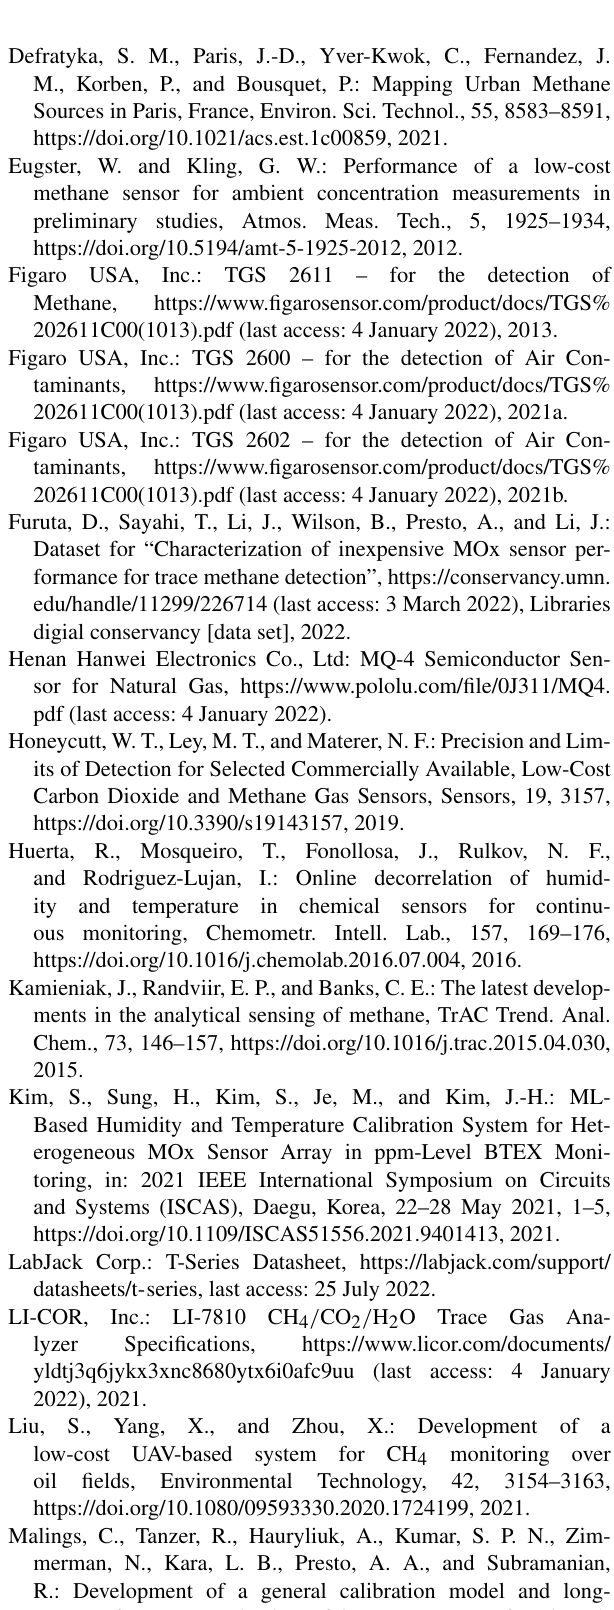
Figaro USA, Inc.: TGS 2611 – for the detection of Methane, Figaro USA, Inc.: TGS 2600 – for the detection of Air Con- taminants, Figaro USA, Inc.: TGS 2602 – for the detection of Air Con-